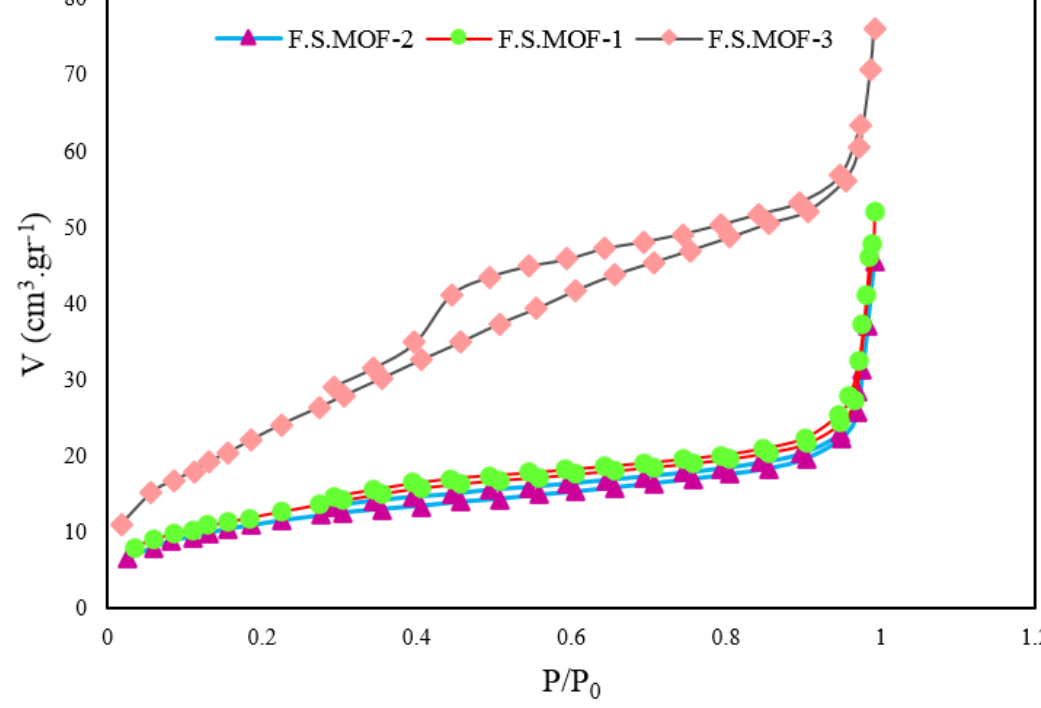
Fig. 9. Nitrogen gas adsorption analysis and specific surface Fig (9): Nitrogen gas adsorption analysis and specific surface area